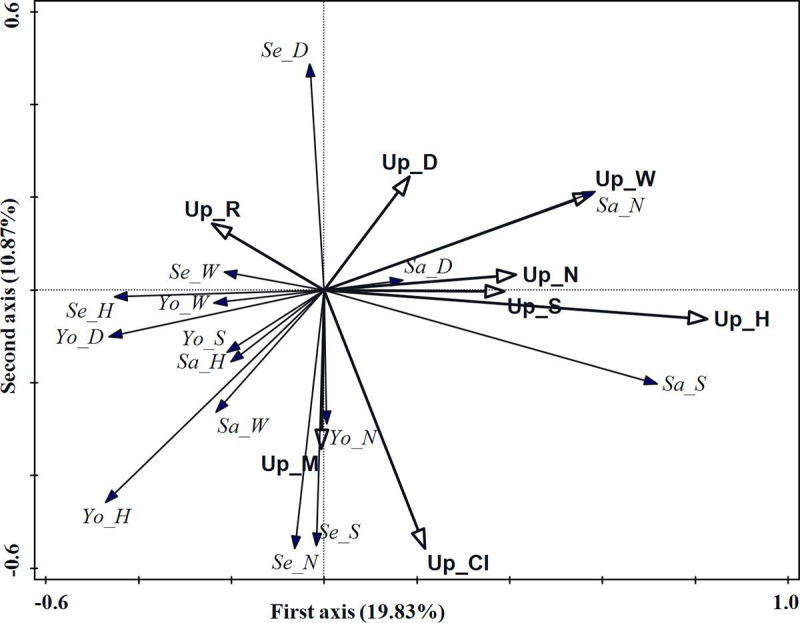
RDA ordination diagram of upper forest stratum structure indices
and regeneration in the evergreen broad-leaved forest.Hollow arrows represent stand structure indices and solid arrows
represent regeneration indicators. Up_M, Up_CI, Up_R, Up_S, Up_DBH,
Up_H, Up_W and Up_N denote the mingling, competition index,
aggregation index, tree species richness index, diameter at breast
height, tree height, crown width and density, respectively. Se_N,
Se_D, Se_H, Se_W and Se_S denote seedling density, basal diameter,
tree height crown width and tree species richness index,
respectively; Sa_N, Sa_D, Sa_H, Sa_W and Sa_S denote sapling
density, basal diameter, tree height, crown width and tree species
richness index, respectively; Yo_N, Yo_D, Yo_H, Yo_W and Yo_S denote
young tree density, diameter at breast height, tree height, crown
width and tree species richness index, respectively.